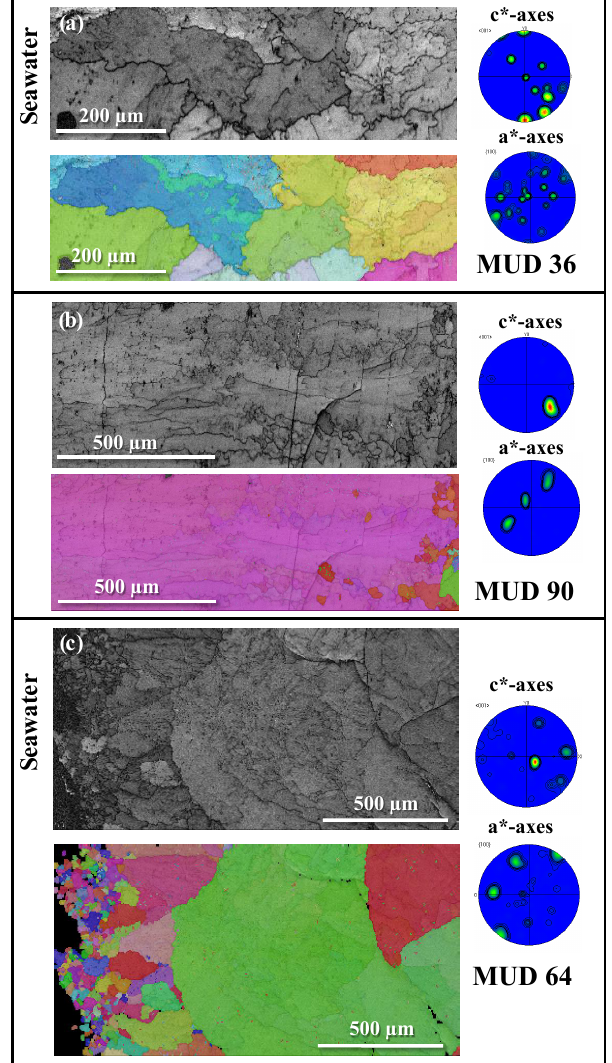
Figure 10. EBSD band contrast maps and colour-coded orientation maps with corresponding pole figures for hydrothermally altered Arctica islandica shells at 175 ◦ C in water simulating burial dia- genesis. EBSD measurements shown in (a) and (b) were taken on shells that were subject to hydrothermal alteration for 7 days, while the measurement shown in (c) was performed on shells where alter- ation lasted for 84 days. At 175 ◦ C, for both alteration times, most of the aragonite has transformed to